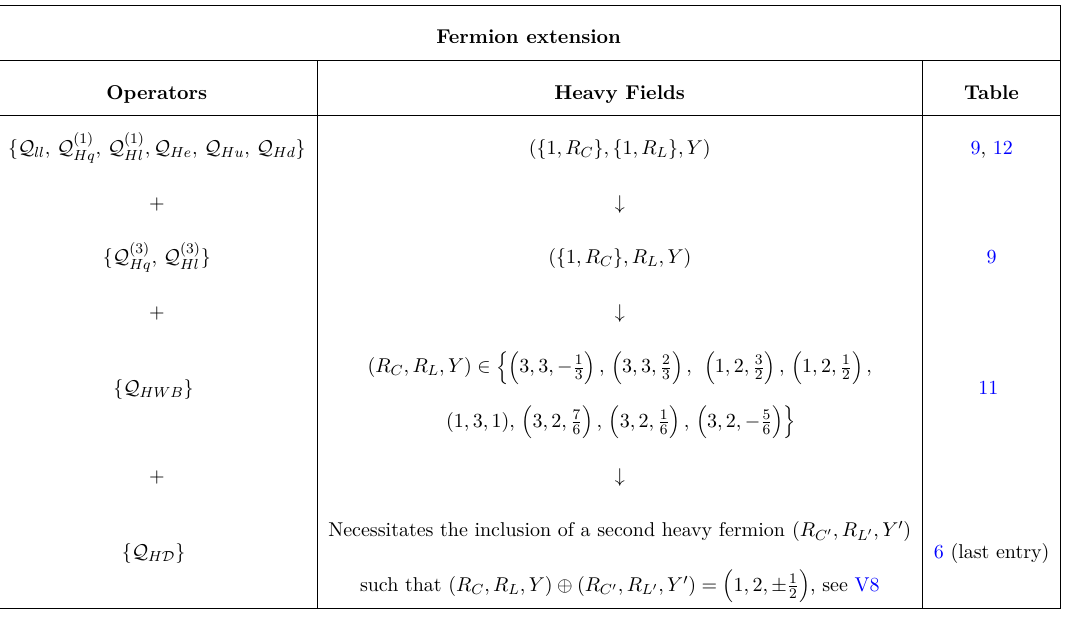
Table 25 . Restrictions imposed on the heavy field representation as we take into account more and more operators relevant to electroweak precision observables. The “+” sign indicates that more operators are being added and “ ↓ ” shows how the permitted representations get modified gradually. For each step we have also referred to the tables where the relevant diagrams have been